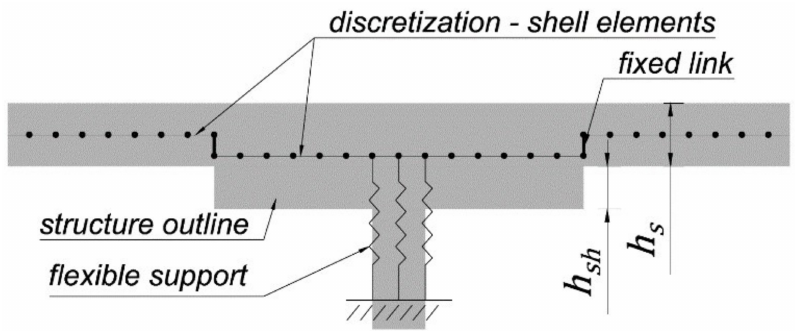
Figure 8. The method of modeling the slab–shear-cap